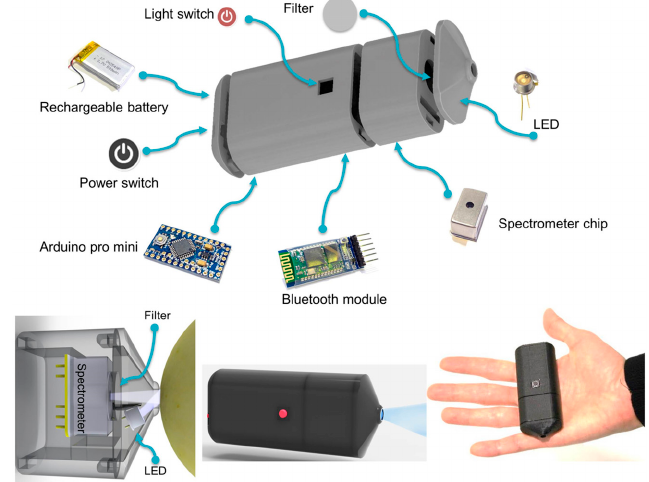
Figure 9. Schematic of the different components of the smartphone spectrometer prototype. Adapted